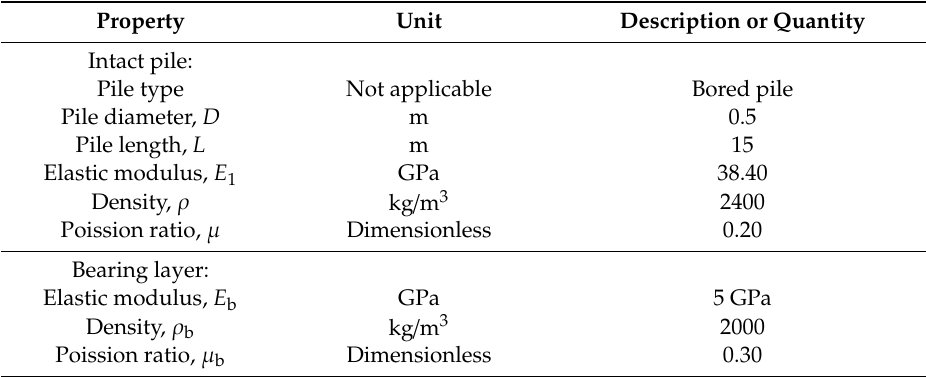
Table 2. Properties of the intact pile (reference pile) and bearing layer.